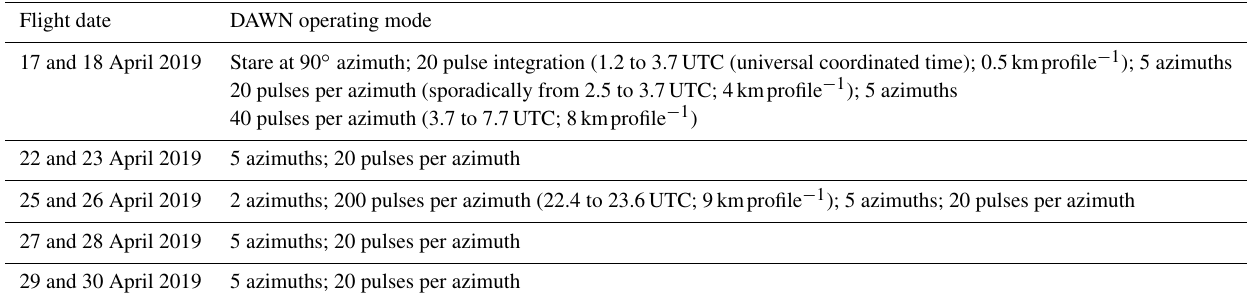
Table 1. A listing of DAWN operating modes throughout the five flights of the campaign and the approximate spacing between profiles. Flight date DAWN operating